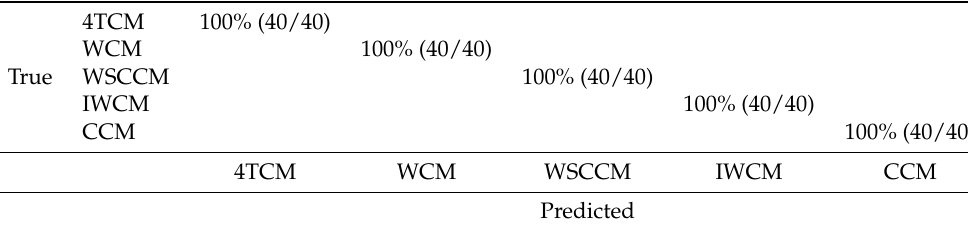
Table 18. Numerical augmentation of the hyperphysically augmented dataset: this confusion matrix shows that all classes were classified correctly and this results in a 100% accuracy.